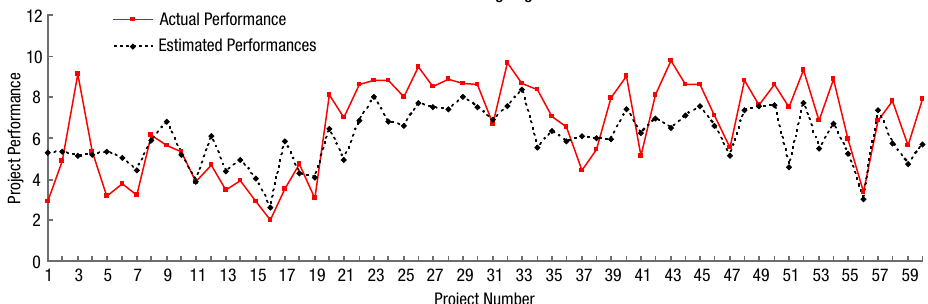
PatternMatching